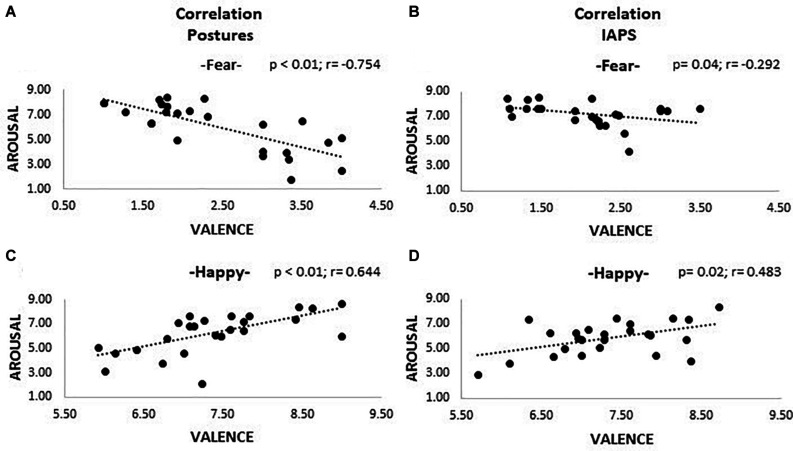
Correlation plots. The picture shows four plots where correlations between valence and arousal are observable. Plots (A) and (C) show the results for the posture trials; (B) and (D) the ones for the IAPS trials. A positive correlation is appreciable for positive emotional pictures (happiness; plots C and D), meaning that higher valence corresponds to higher activation; the opposite is observable for negative pictures (fear; plots A and B), even though for IAPS, stimuli significance was not reached after Bonferroni correction. Both valence and arousal are reported as values on the 0–9 Likert scale. Legend: $ = p > 0.05.